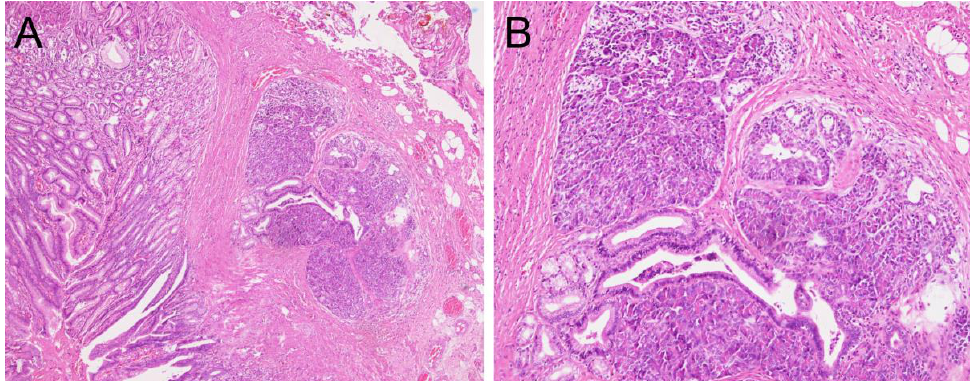
Figure 3. ( A ) Heterotopic pancreatic tissue in the deep gastric submucosal area (hematoxylin and eosin stain, 20×). ( B ) Enlarged image of heterotopic pancreatic tissue showing acini, small ducts with islets of Langerhans (hematoxylin and eosin stain, 100×).